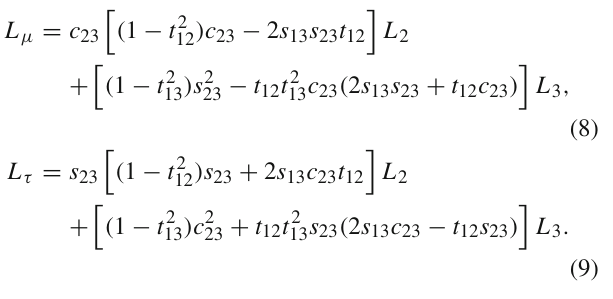
Fig. 2. One may think that it is also possible to have | L μ,τ | (cid:6) | if L ∼ − L | L 2 , 3 2 3 . However, our numerical testing showed that generically Max [{| L αβ | α (cid:7)= β }] (cid:2) Max [{| L αα |}] . Hence, on general grounds one expects to